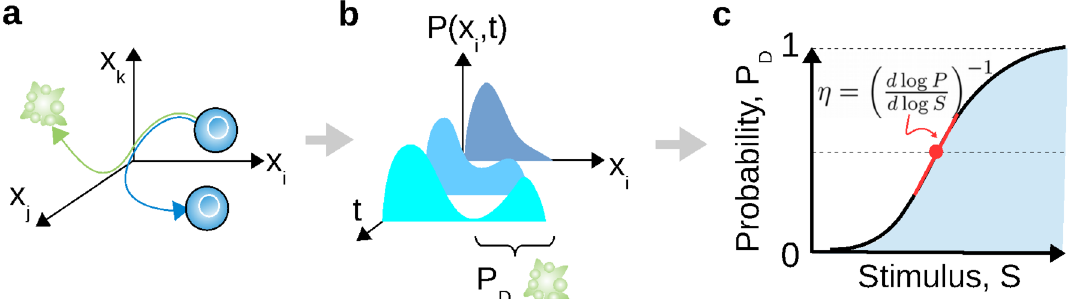
Figure 1. Dynamical and probabilistic schemes of cell-fate decisions. ( a ) State-space trajectories diverging toward distinct cellular phenotypic states. ( b ) Establishment of a bimodal probability density function. ( c ) Fate probability curves whose slope is quantified by a fractionality index ( η